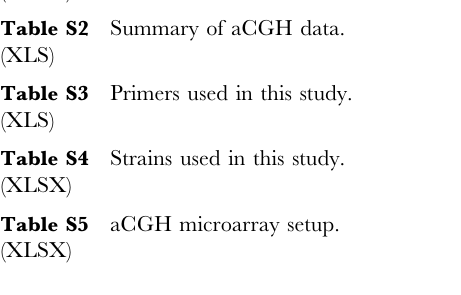
Table S1 GCR rates compared to segmental duplication assay